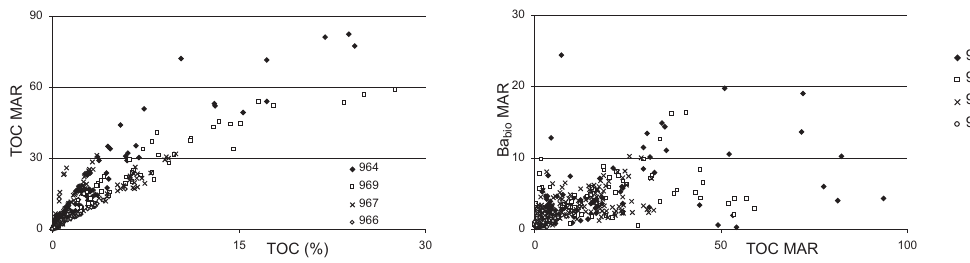
Fig. 13. Correlation between TOC vs. TOC-MAR and between TOC vs. Ba bio MAR for Sites 964, 969 and 967. Maximun TOC values do not correspond with highest Ba bio MAR and viceversa.